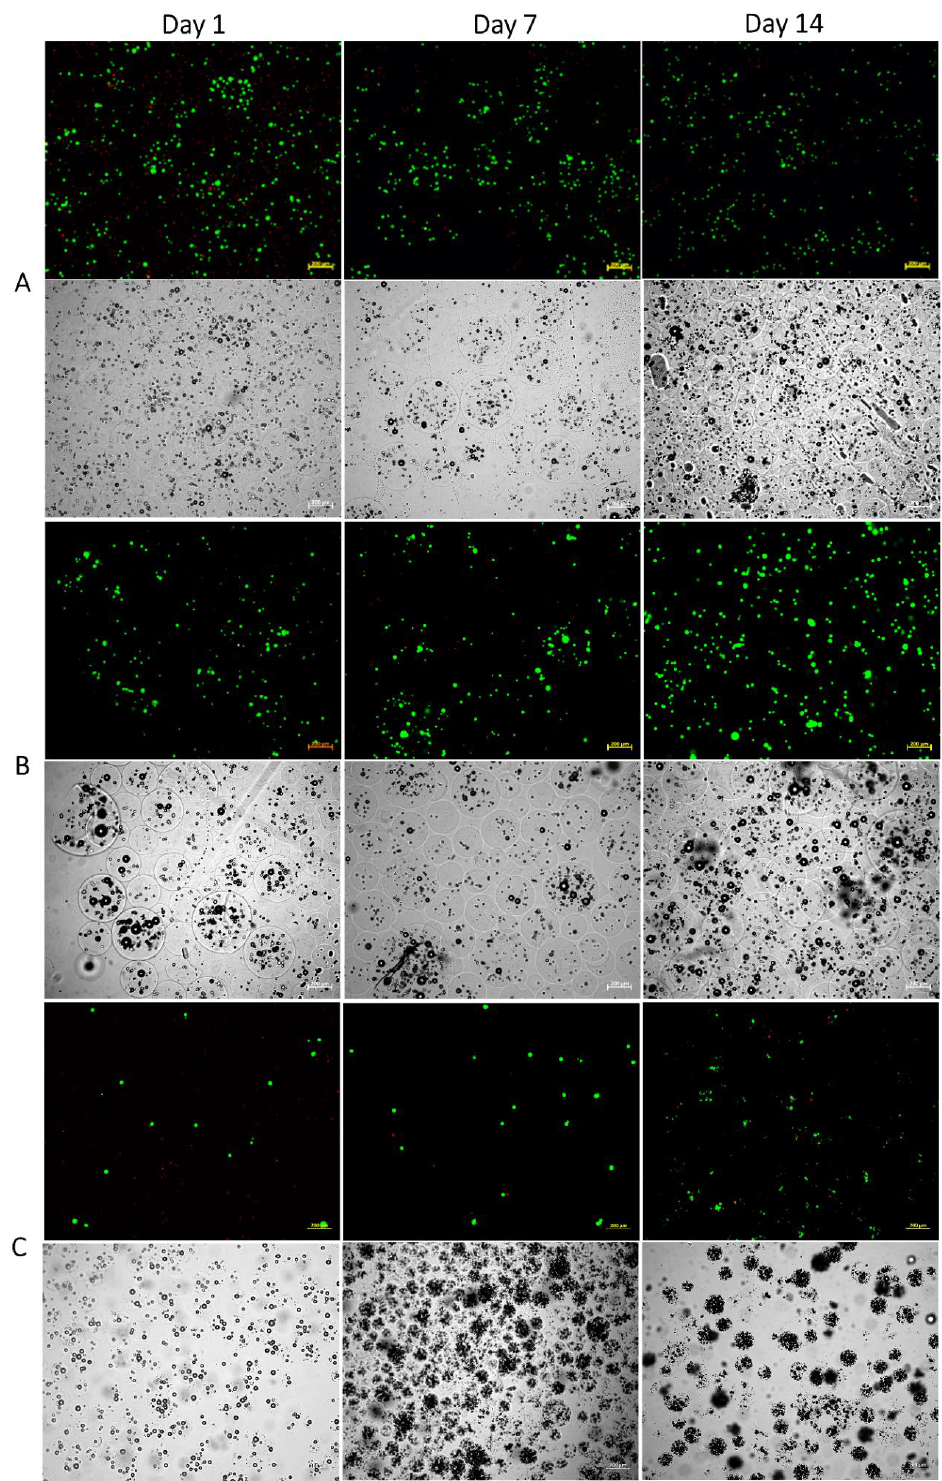
Figure 3. Microscope photographs of alginate beads containing hBM-MSCs observed in fluorescence and bright-field modes. hBM-MSCs were encapsulated in MVM alginate beads (2 × 10 6 cells/mL alginate) at agitation rates of ( A ) 800, ( B ) 900, and ( C ) 1000 rpm, and cultured for up to 2 weeks. For the fluorescence mode, cells were stained with FDA/PI. The scale bar is 200 µ